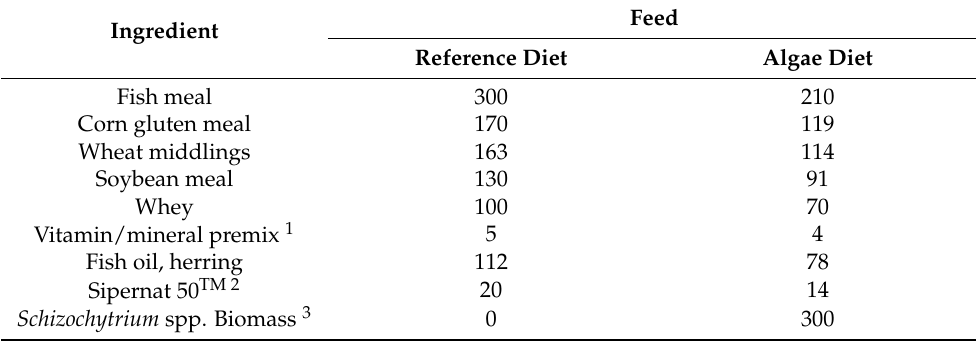
Table 2. Ingredient composition (g kg − 1 ) of the experimental diets. Feed Ingredient Reference Diet Algae